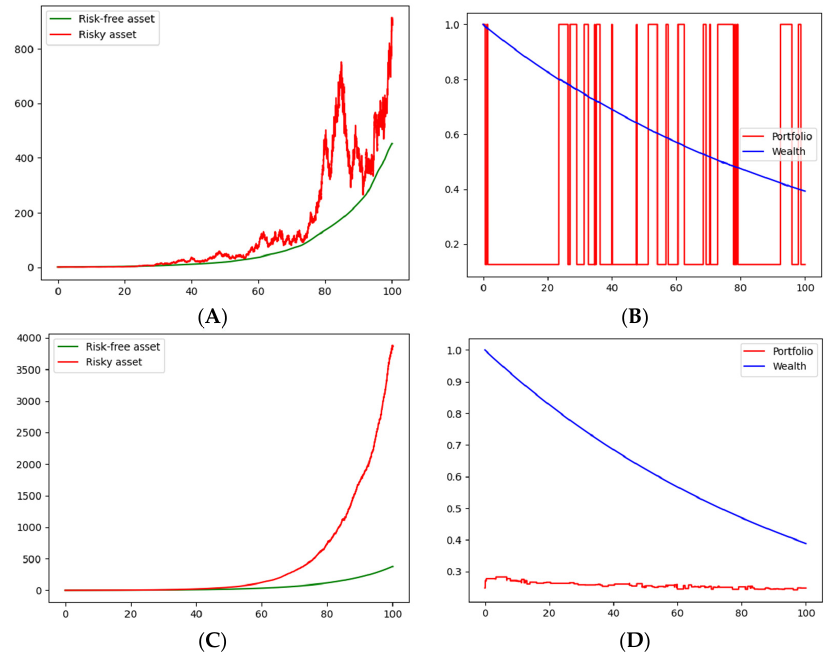
Figure 3. Second scenario, logarithmic utility, k = 2, and a 0 = r 0 = S 0 = X 0 = 1. Natural momentum ( µ 1 = 0.12, r 1 = 0.08, σ 1 = 0.2 ) vs. inferred momentum ( µ 2 = 0.06, r 2 = 0.055, σ 2 = 0.2, with ρ = 0.01 ) . ( A ) Price realization, ( B ) Portfolio strategy, ( C ) Average of price realizations, and ( D ) Average of portfolio strategies. Authors’ own